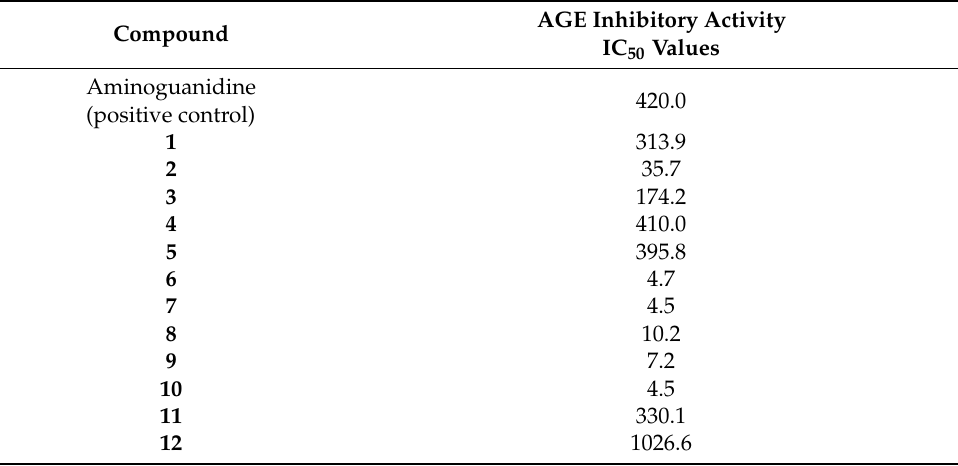
Table 4. IC 50 values of the AGE inhibitory activity test of the isolated